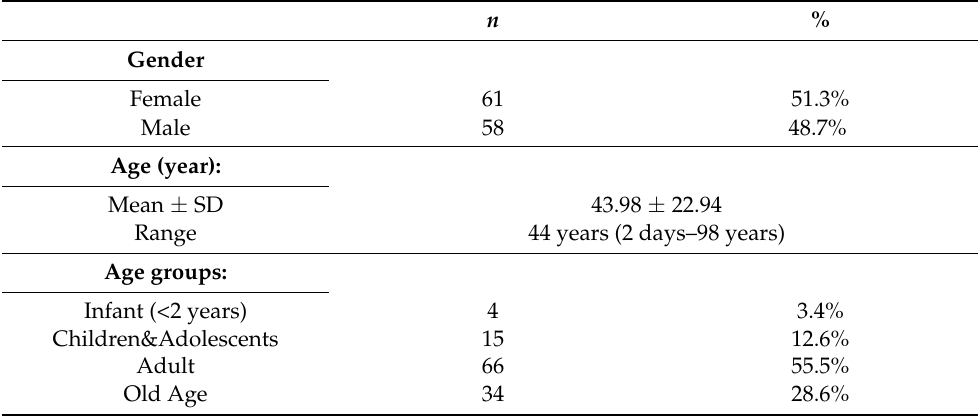
Table 1. Demographic data of CRKP